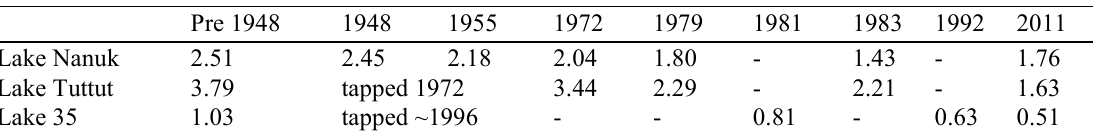
Fig. 4 Lake Nanuk: (a) surveyed, and (b) images showing the progressive tapping and filling. Table 1 Lake size reduction after tapping, in km 2 .